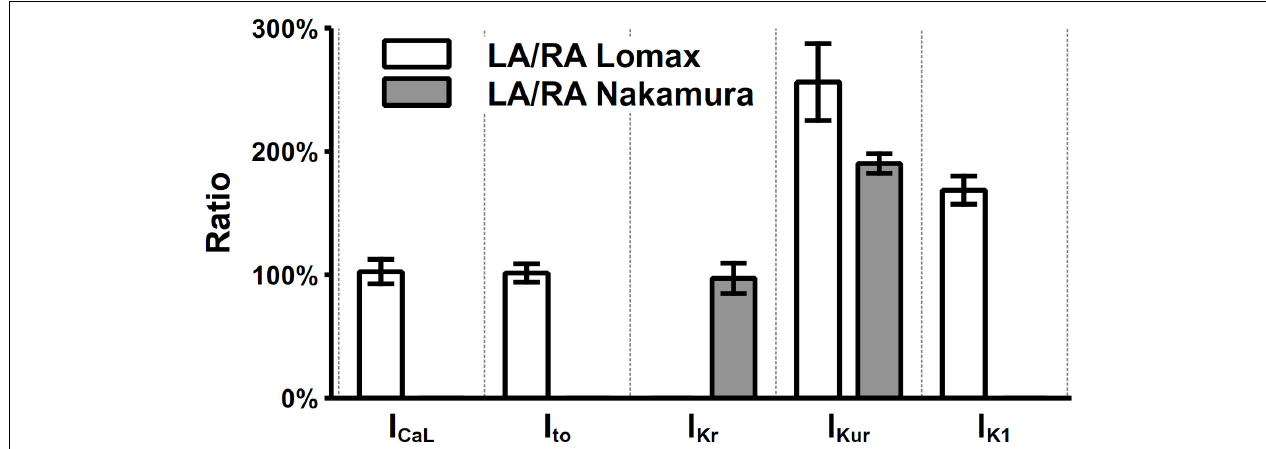
FIGURE 7 | Heterogeneity of current densities between left and right atria. The current densities in left atria were normalized to their counterparts in the right atrium. The values of I CaL , I to , I Kr , I Kur , and I K1 were extracted at clamp voltages of 0, 35, 25, 35, and –105 mV,